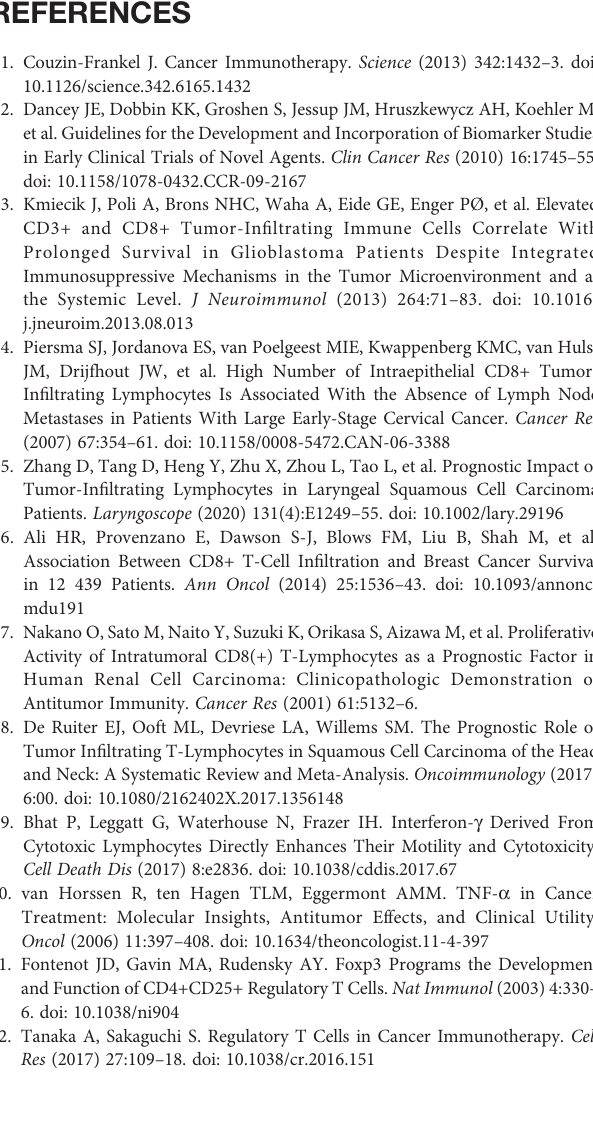
were included in the full multivariate model (B) . The simple model (C) was limited to variables that were signi fi cant in the full model at the p ≤ 0.05 level. Supplementary Table 3 | MKi67+CD8+ Univariate and Multivariate Regression Analysis. The association between MKi67+CD8+ cells/mm 2 in tumor biopsies and eachvariable ofinterest was determined inalinear mixedeffectmodel using restricted maximumlikelihoodestimation (A) .Variableswithap-value ≤ 0.1oraneffectsizeof>2 or <0.5 were included in the full multivariate model (B) . The simple model (C) was limited to variables that were signi fi cant in the full model at the p ≤ 0.5 level. Supplementary Table 4 | Correlation of Marker Level With Time Since Prior Cancer Therapy. Supplementary Table 5 | Clinical Variable Details for Patients in Figure 4 . Supplementary Figure 1 | Within Patient Heterogeneity by Speci fi c Lesion Type. Individual biomarker measurements were plotted by speci fi c lesion type with a line connecting values from the same patient. The difference in Log2 marker level between the metastasis and its paired primary lesion was plotted to calculate what percent of lymph node (ln) metastases (A) , liver metastases (B) or lung metastases (C) displayed a 2-fold (Log2 ≥ |1|) or greater